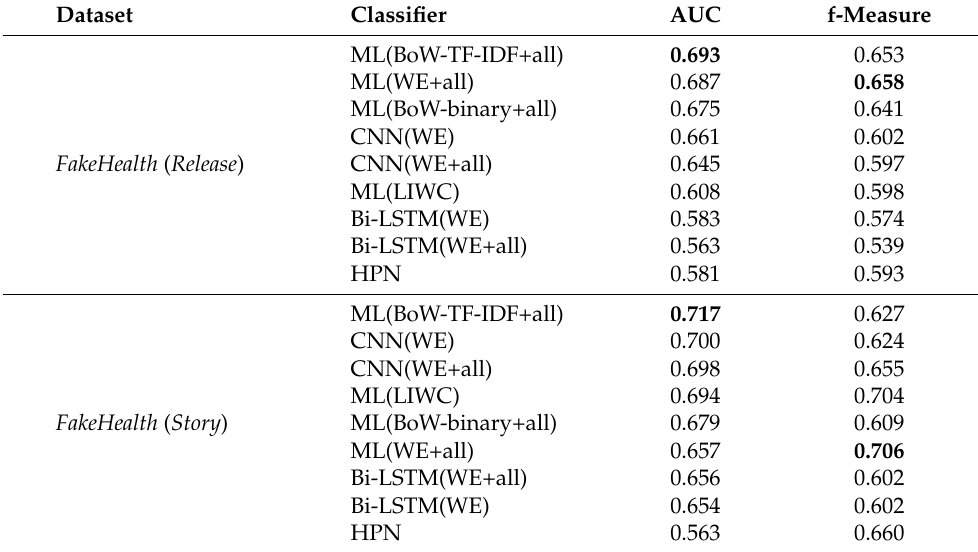
Table 6. Global evaluation results for the FakeHealth dataset.